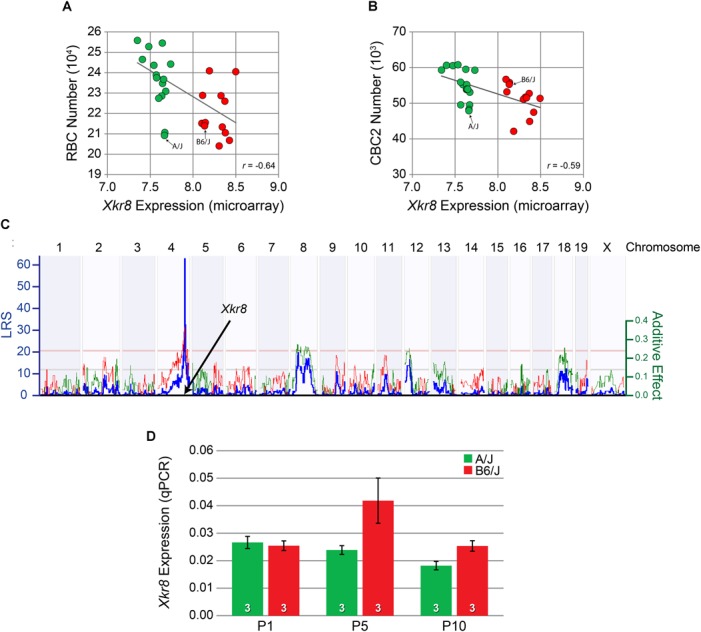
Xkr8 expression was negatively correlated with both RBC number (A) and CBC2 number (B) across the RI strain set. Those strains carrying the B haplotype at the Xkr8 locus (red) all had lower transcript levels relative to strains carrying the A haplotype (green). Expression in each of the parental B6/J and A/J strains is also indicated. (C) The variation in expression of Xkr8 across the RI strains mapped to the same genomic locus for bipolar cell number, indicating the presence of a variant in Xkr8 affecting gene expression (i.e., a cis-eQTL). (D) qPCR for Xkr8 transcript levels showed significantly greater developmental expression in the B6/J strain relative to the A/J strain (p < 0.05), being most conspicuously greater at P5. Retinal mRNA was pooled from individual eyes in each litter, at each time-point. n = the number of litters per strain examined at each age.